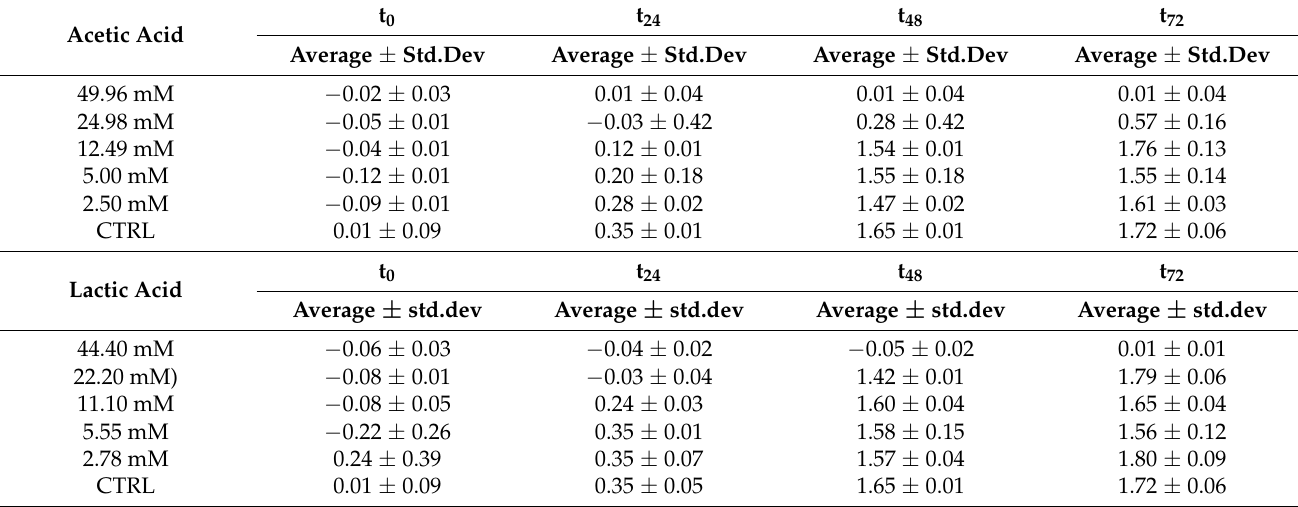
Table 1. Optical Density of P. brenneri MGM3 suspensions in Brain Heart Infusion (BHI) broth at 30 ◦ C in presence of different concentrations of lactic and acetic acid (the value indicates the difference towards the respective blank sample). MIC detected are written in